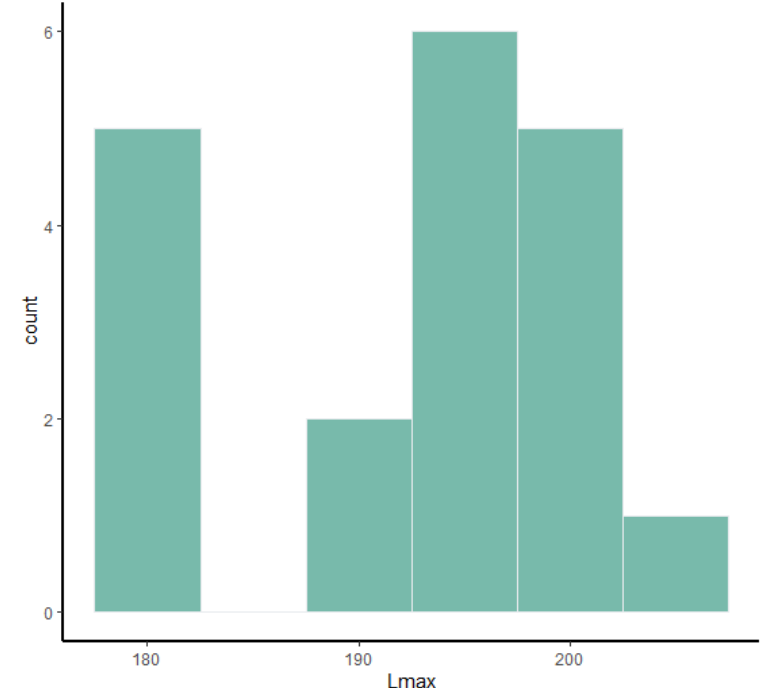
Figure 5. Frequency distribution of the maximum length (Lmax) in the MCIII of S. etruscus.